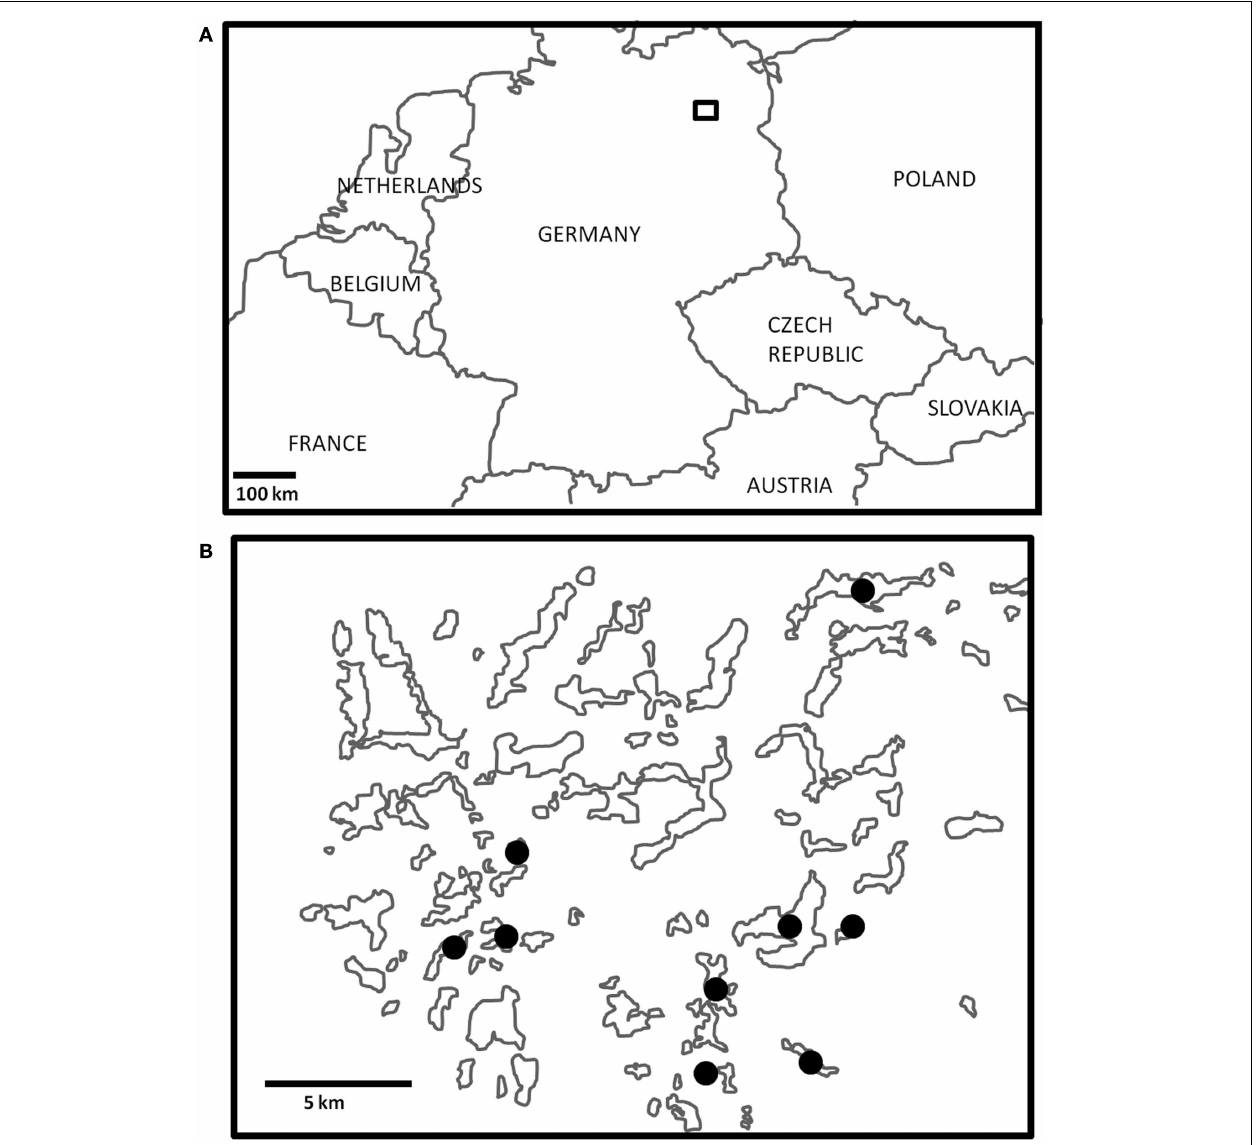
FIGURE 1 | (A) The general study region in northeast Germany is outlined by the small square box, which is enlarged in (B) .Three Lakes sampled are denoted by black dots.